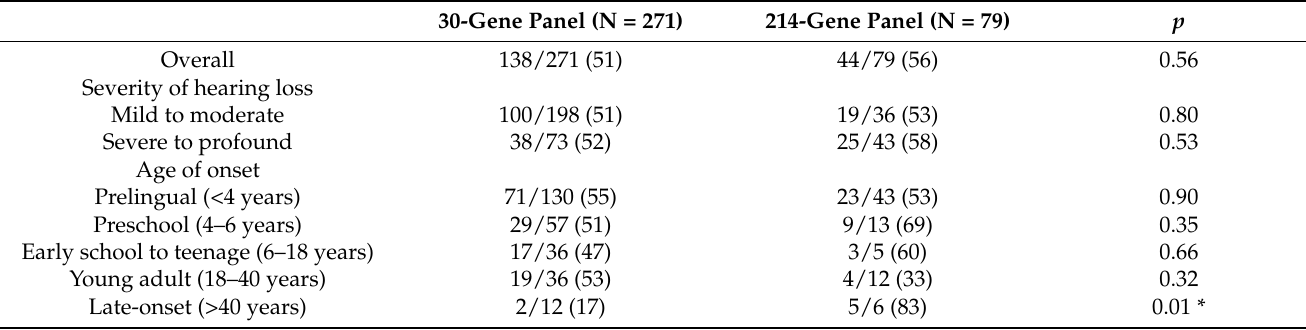
Table 4. Comparison of diagnostic rates between different targeted NGS